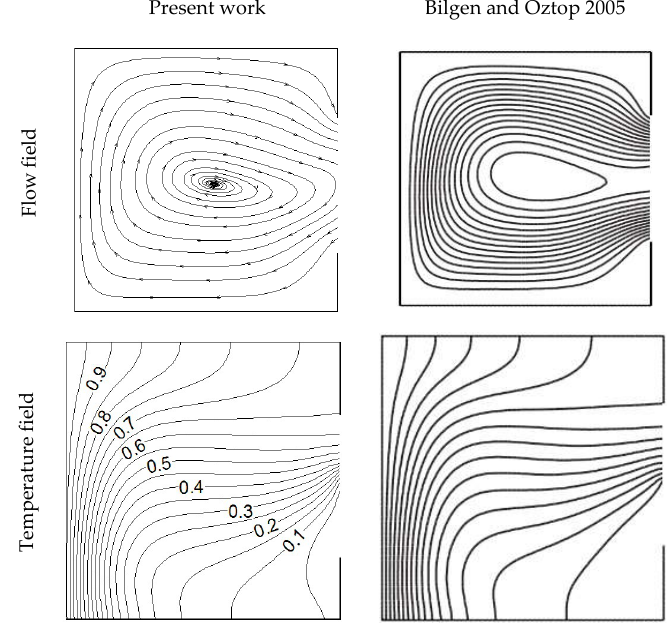
Figure 3. Comparison of results with two dimensional solution of Bilgen and Oztop [14] for Ra = 10 4 .